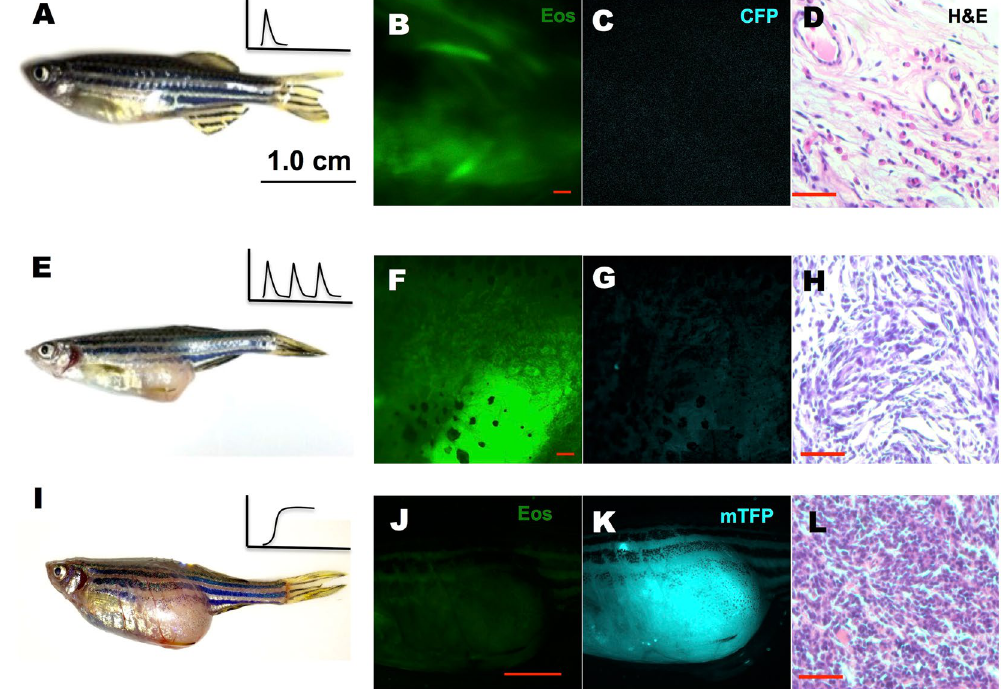
Figure 3. Tumor induced by periodic or constitutive, but not transient activation of kRASG12V expression. In the latter system, one-time activation of kRASG12V expression was induced by transient cyclofen incubation or photo-activation of caged cyclofen at 1dpf ( A ). Periodic kRASG12V expression was achieved by 1 day incubation in 2 μ M cyclofen every 5 days for a course of two months ( E ). ( B – D ) Transient induction of kRASG12V did not affect normal development (as shown by the histopathological staining) with no CFP expression in one-year old fish. ( E – H ) Tumors were observed (albeit rarely) in fish periodically treated with cyclofen. A representative one-year old fish displayed a clear tumor ( E ) revealed by histopathological staining ( H ). Interestingly, the cells in the tumor still expressed EosFP ( F ), but lost CFP expression ( G ). ( I – L ) Constitutive kRASG12V expression following light-activation of caged cyclofen induced tumor ( I ) in 5 month- old fish as revealed by both fluorescent markers ( J , K ) and H&E staining ( L ). Scale bar: B, D, F, H, L 200 μ m; J, 1